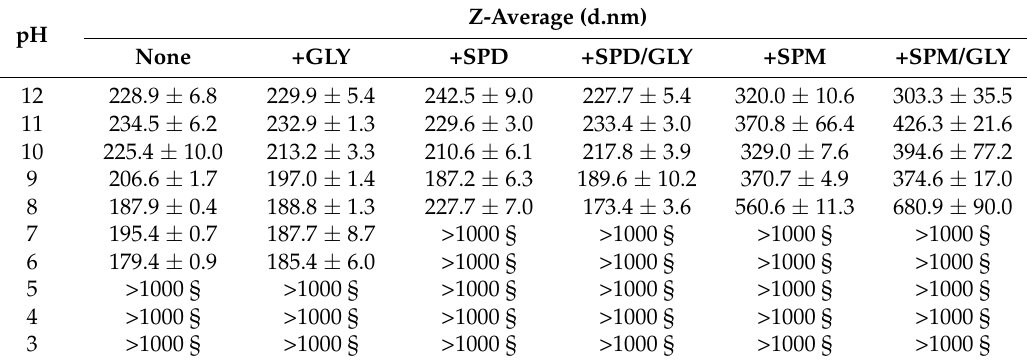
Table 3. Effect of 5 mM polyamines (PAs) on Z-average of the nanoparticles contained in the 80 °C-treated BVPC FFS measured at different pH values both in the absence and presence of 42 mM GLY *.